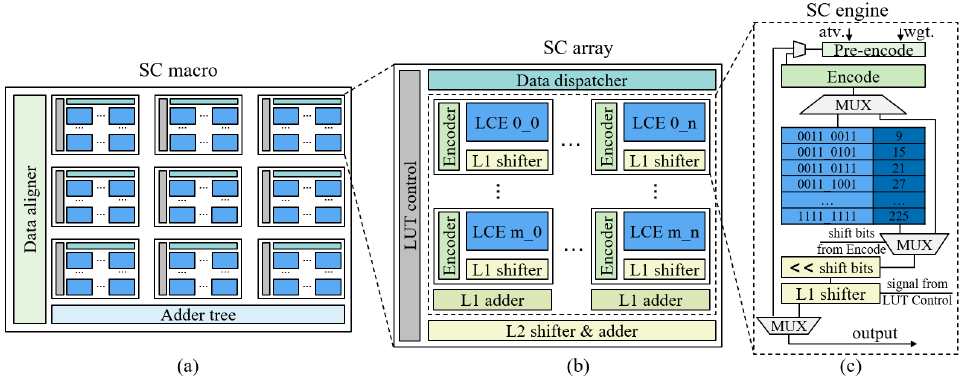
Figure 4. Structure of SC (search-based computing) macro. ( a ) SC macro, which contains 9 SC arrays. ( b ) SC array, which includes 16 SC engines. LCE indicates the LUT-based computing engine. ( c ) SC engine, the basic computing